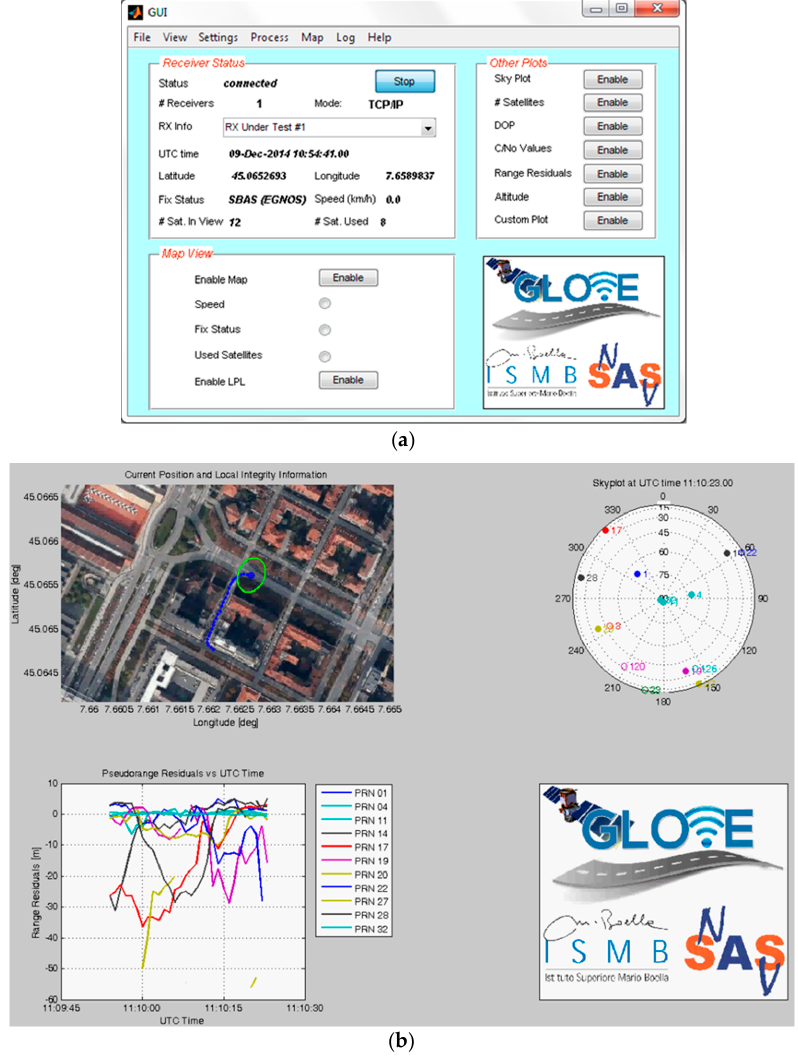
Figure 10. Screenshots of the local integrity software developed in MATLAB ® environment for demonstration purposes: ( a ) Graphical User Interface; ( b ) Some results displayed in real-time.